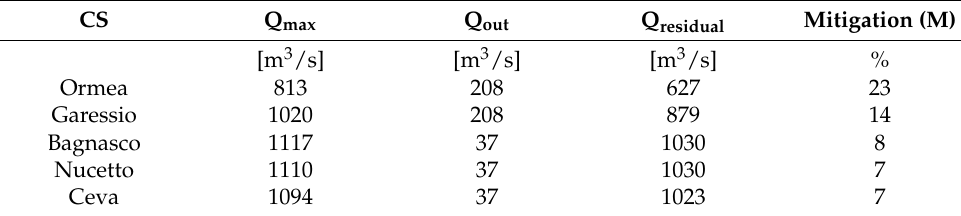
Table 11. The combined mitigation effect of the Negrone and Tanarello Rivers dams if they had a height of 30 m; the combined outgoing flow rate is equal to 208 m 3 /s, but is valid only for the first two control positions; elsewhere only the 37 m 3 /s value of the Tanarello River is